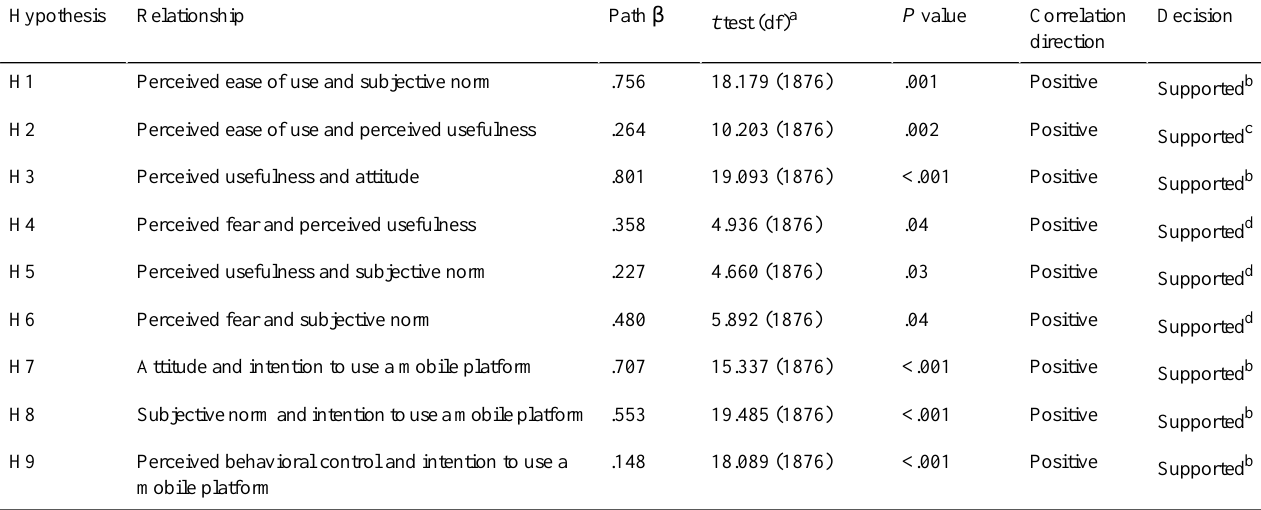
Table 8. Summary of hypotheses testing